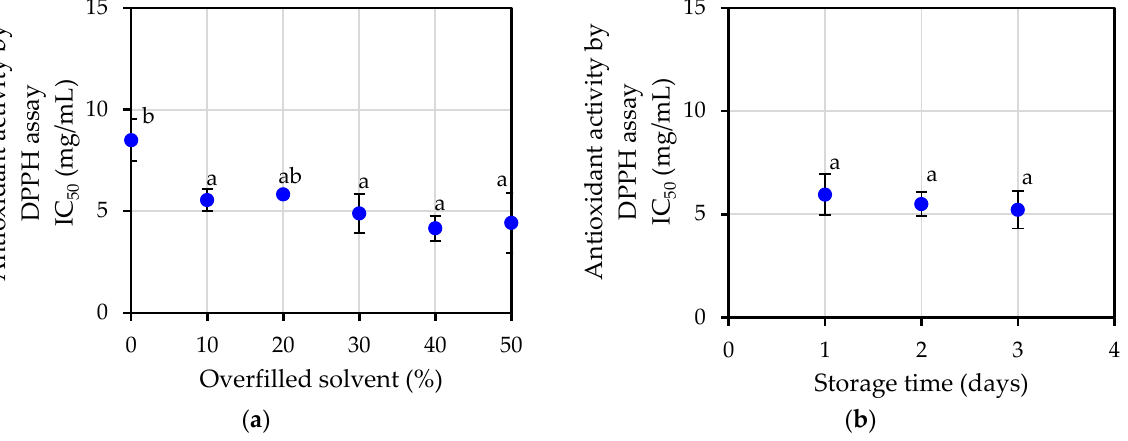
Figure 6. Antioxidant activity by DPPH assays of jasmine essential oil: ( a ) at varying percentage of overfilled solvent; ( b ) at varying storage time. Different letters a, b in the same figure indicate that values are significantly different ( p < 0.05).